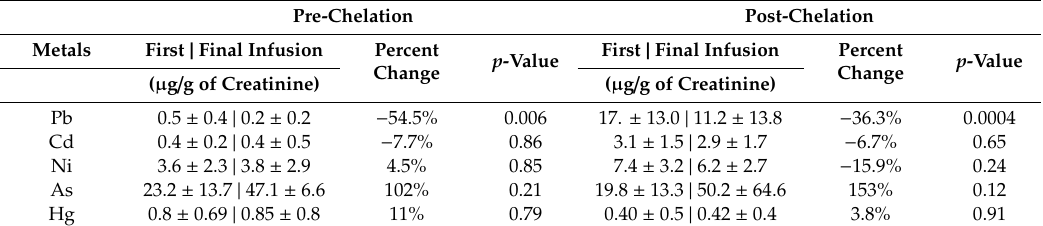
Table 1. Pre-chelation and post-chelation metals at the first and final infusion: Mean urinary metal levels ± SD of lead (Pb), cadmium (Cd), nickel (Ni), arsenic (As), and mercury (Hg) expressed in µ g / g of creatinine in patients pre-chelation (left) and post-chelation (right) for the first and final infusions. Pre-Chelation